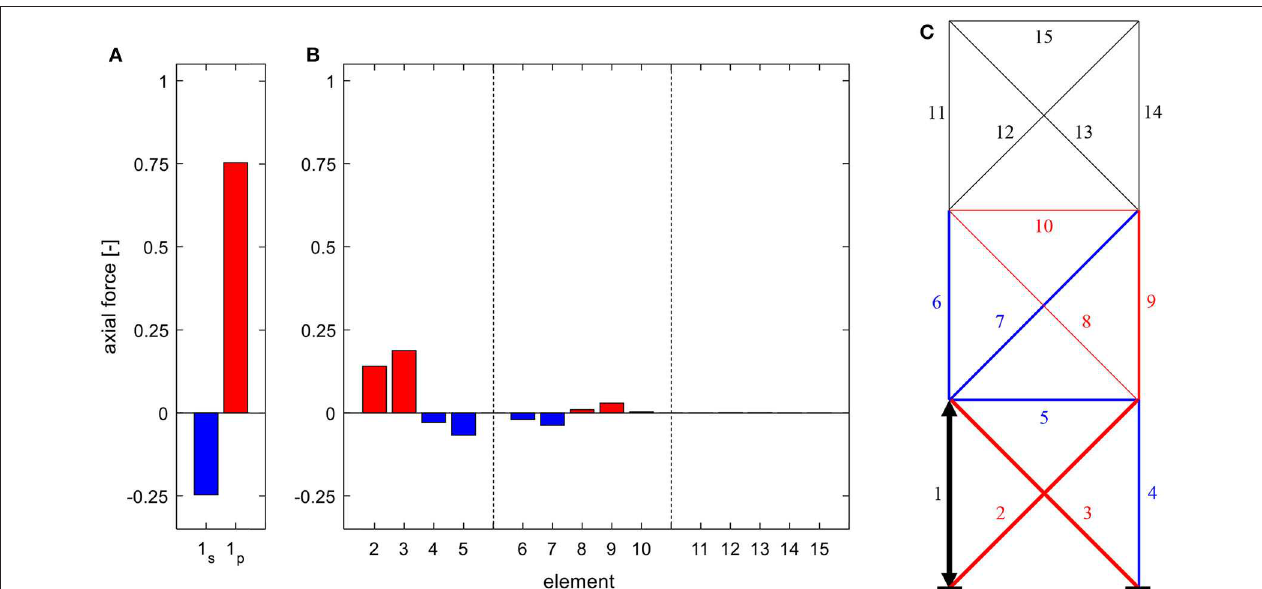
FIGURE 8 | Axial forces in (A) the actuated element for serial (index s ) and parallel (index p ) linear actuation, (B) the remaining structure due to the actuation of element 1 (C) , for a truss with rigid joints and beams with increased flexural rigidity.